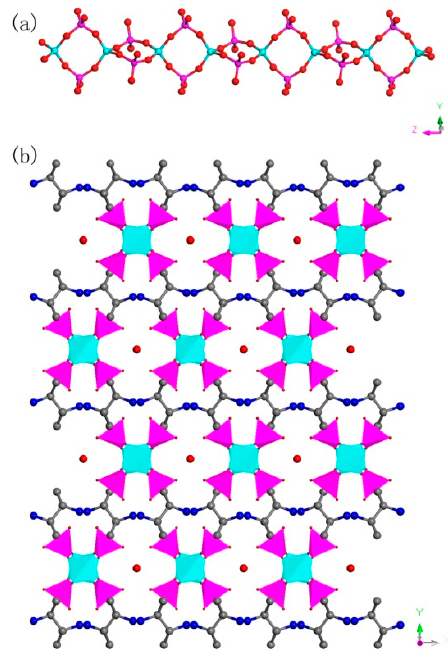
Figure 5. ( a ) One-dimensional (1D) chain structure of 1 along the (001) direction. ( b ) The ABAB dislocated stacking structure of 1 along (010) direction. P, pink; Al, cyan; N, blue; O, red; C, gray. All hydrogen atoms of organic amine are omitted for clarity.